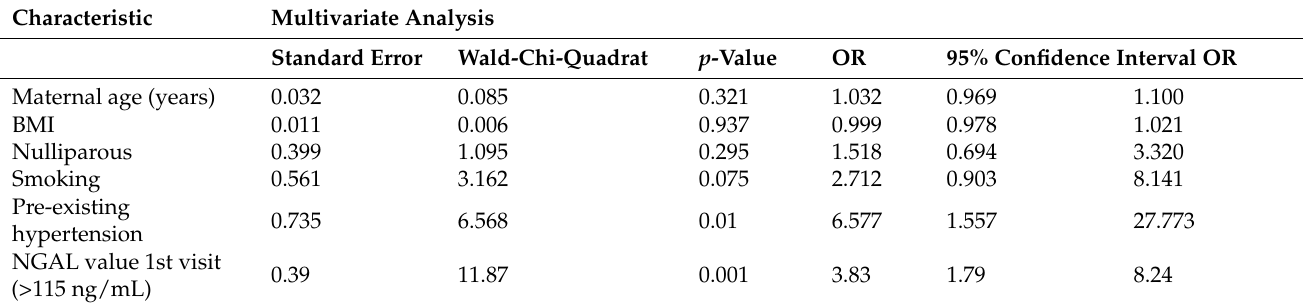
Table 3. Predictive model for the development of PH or PE: binary logistic regression model ( n = 242).